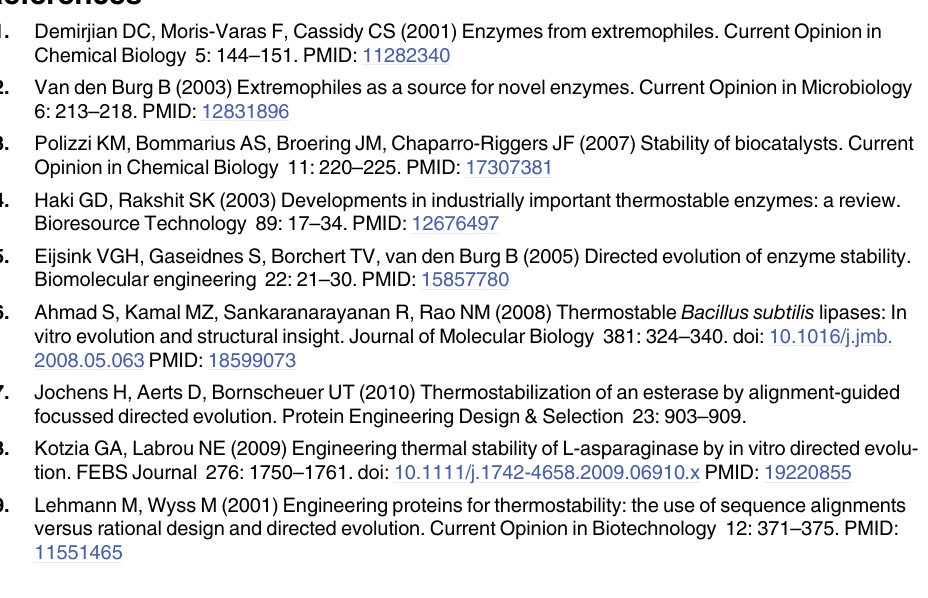
characterized experimentally. S1 Table. Bs LipA variants with negative Δ T p S2 Table. Confusion matrix for two possible outcomes Δ T > 0 and Δ T < 0 for classifying 22 (15) Bs LipA variants with respect to predicted and experimental changes in thermosta- bility related to WT Bs LipA. S3 Table. Bs LipA variants and mutagenesis primer